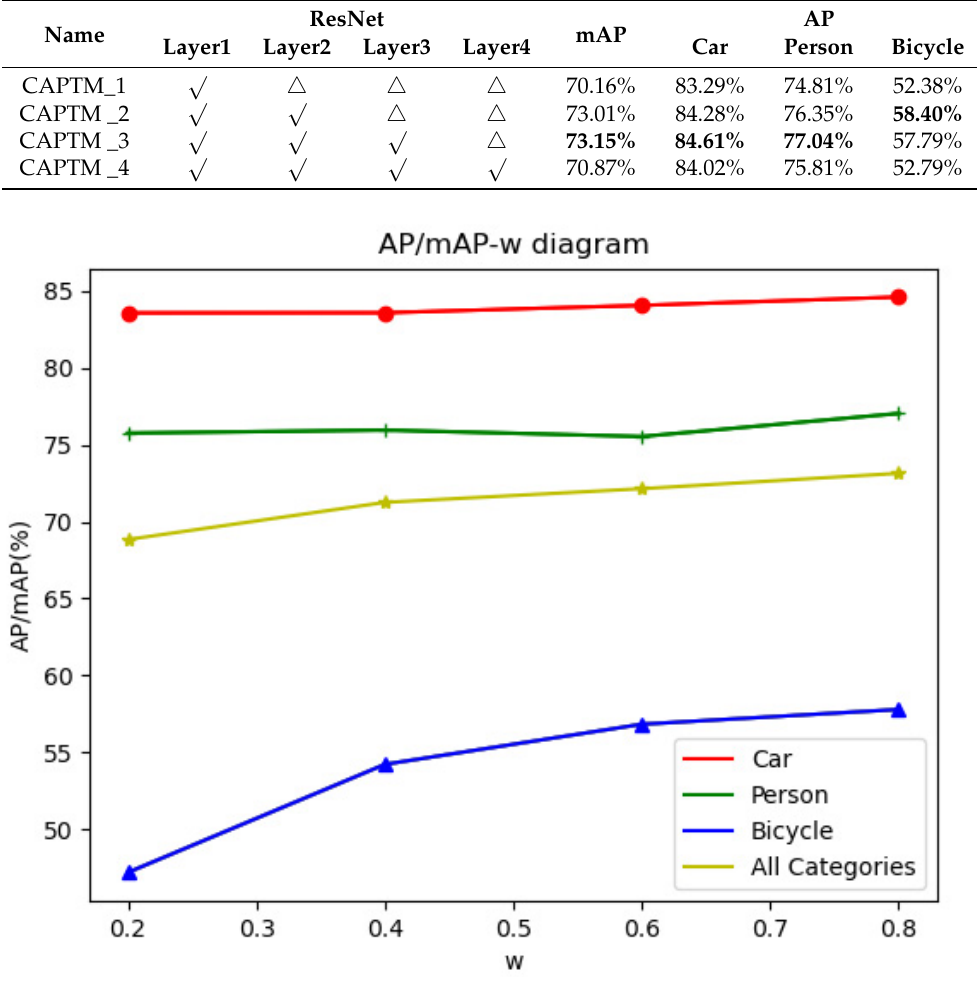
Table 4. The results of the CAPTM module after temperature information was inserted into different layers. Note: √ indicates the use of the CAPTM module, △ indicates the use of the CBAM module, and CAPTM_x indicates the use of the CAPTM module for the first x layers in ResNet.